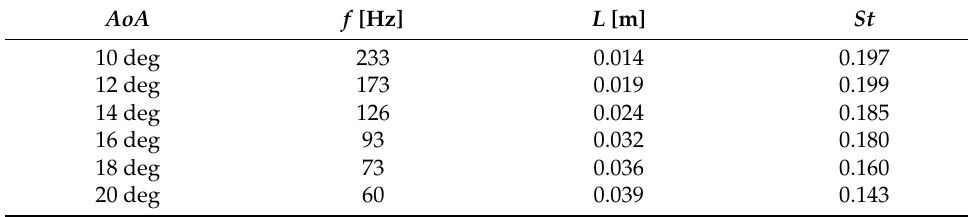
Figure 9. Velocity field, pressure coefficients and spectra of the fluctuating moment at AoA = 8 ◦ , 12 ◦ , 16 ◦ and 20 ◦ , obtained from the refined GEKO unsteady CFD simulation. Table 3. Strouhal numbers of the detached flow for different angles of